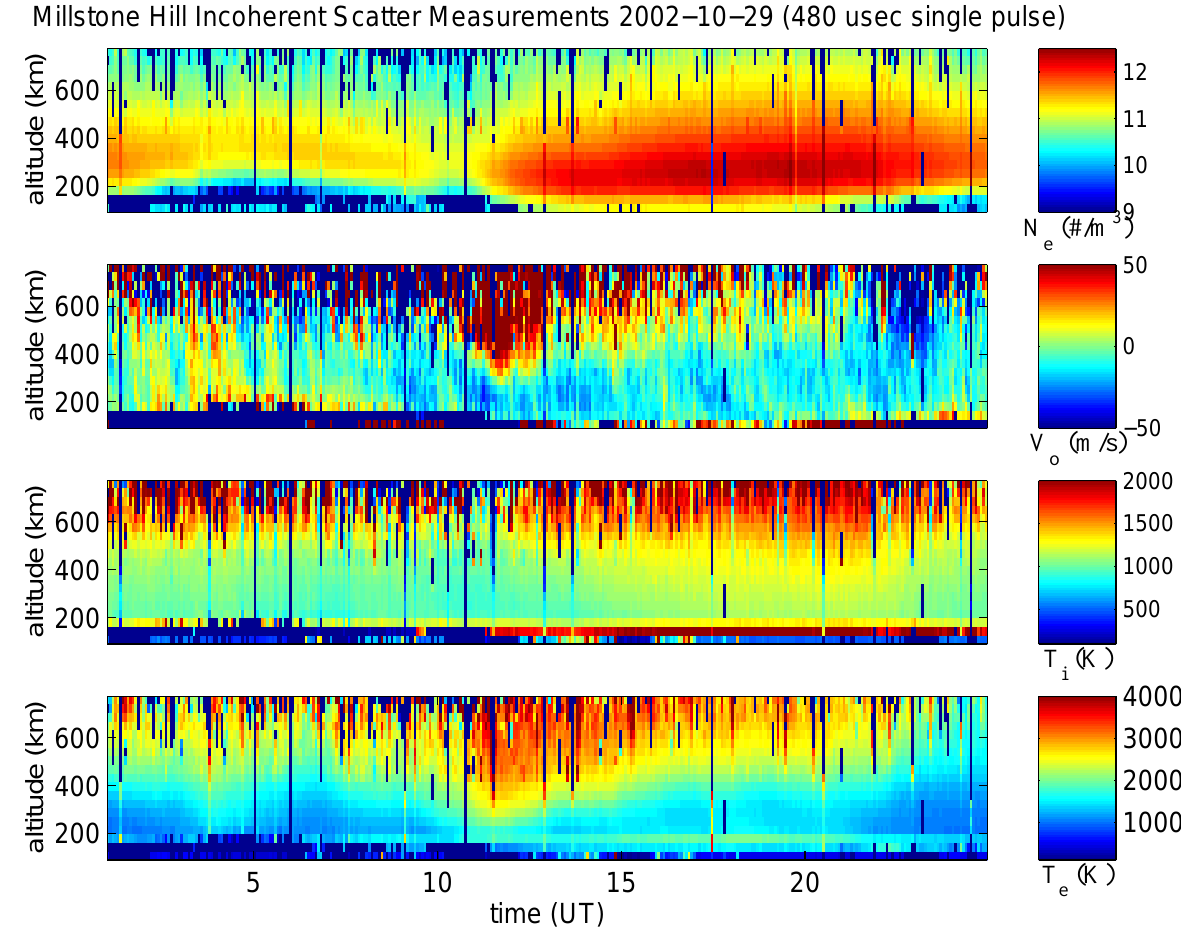
Fig. 10. Fitted results from a day of single pulse data at Millstone Hill processed using the Software Radar system. Electron density (log), Doppler velocity, ion temperature, and electron temperature are shown over a period of 24 hours. Four-minute integrations are used in this example but the data can be reprocessed from the voltage level to produce any integration time required and statistically